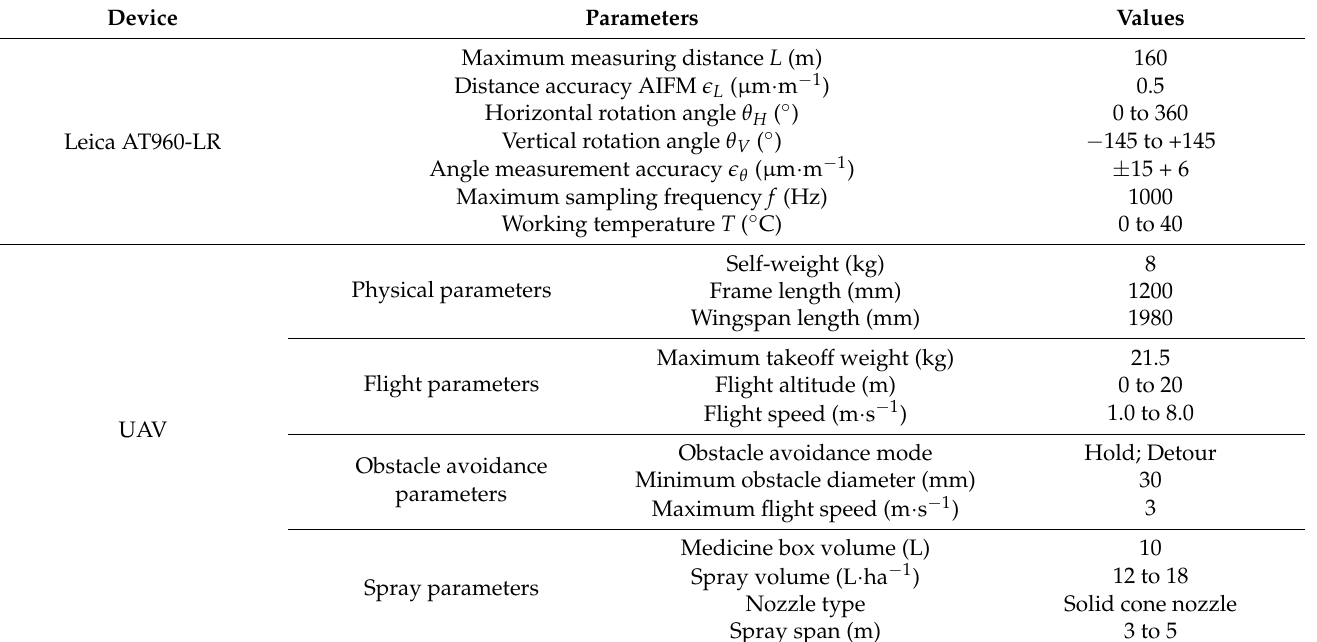
Table 1. Performance parameters of experimental device.